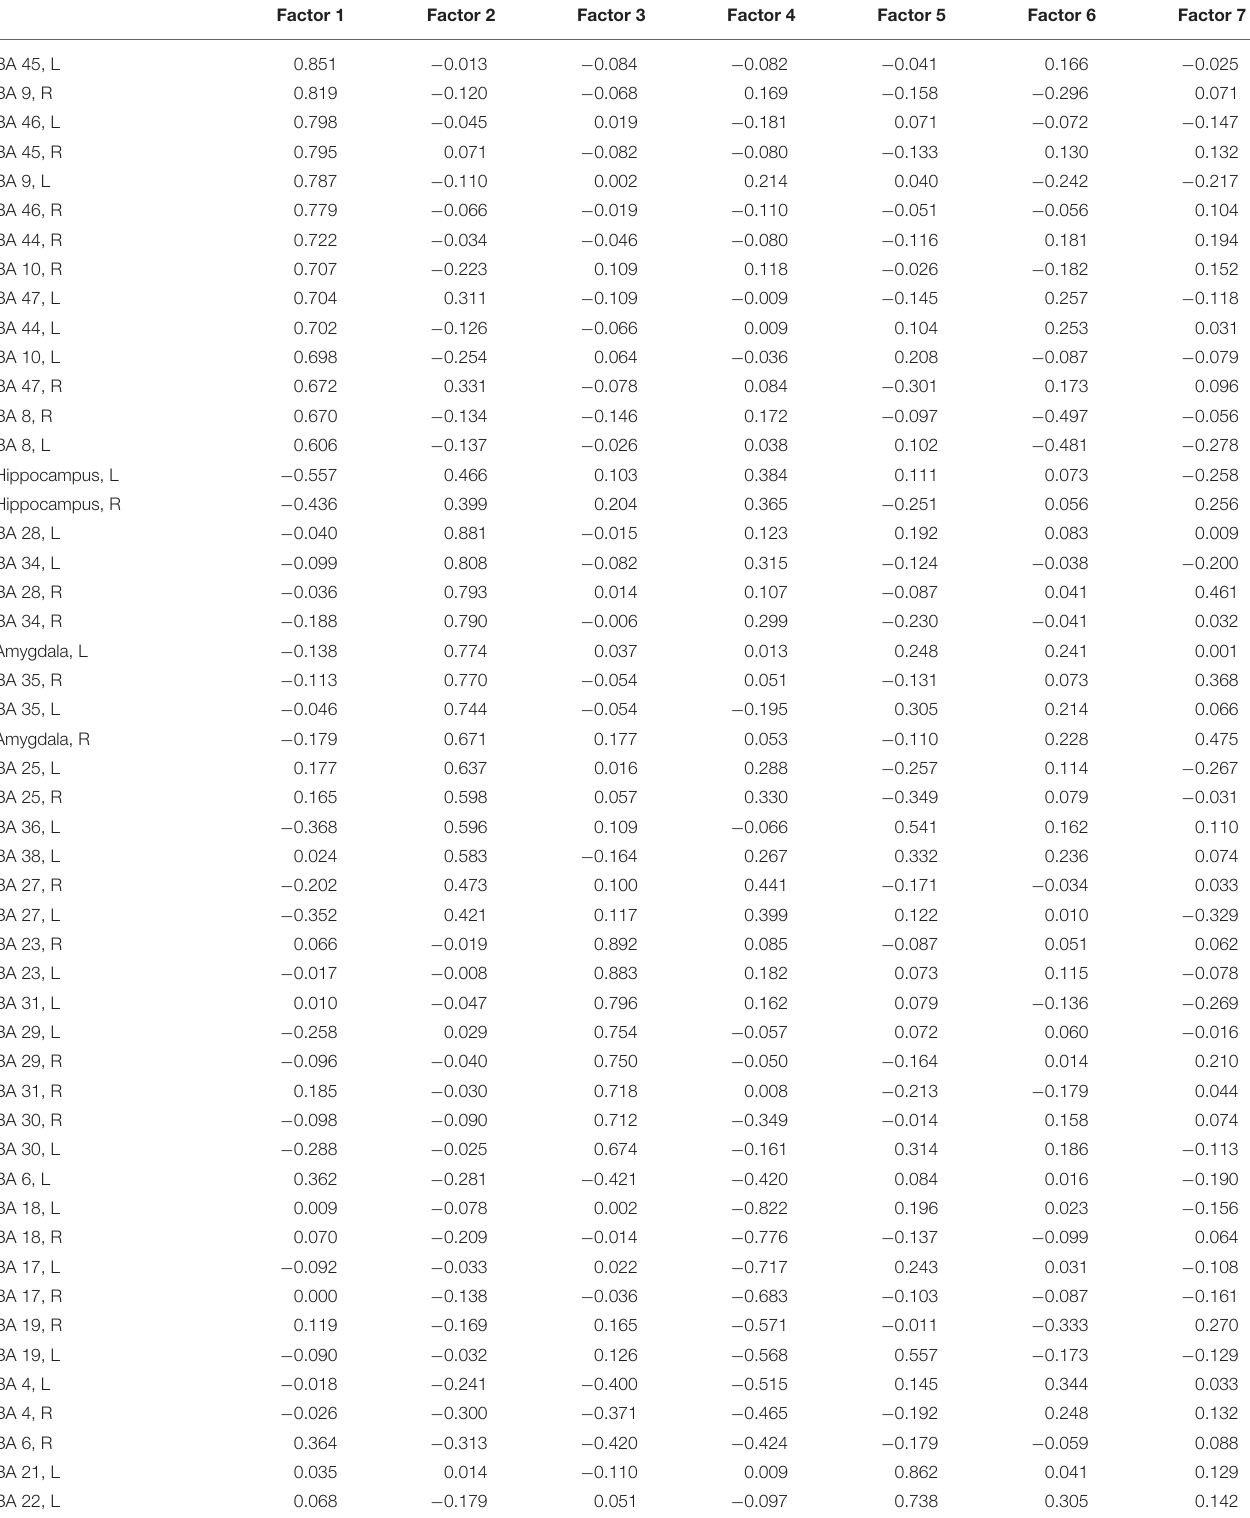
TABLE 2 | Factor loadings for the cerebral regions considered after varimax